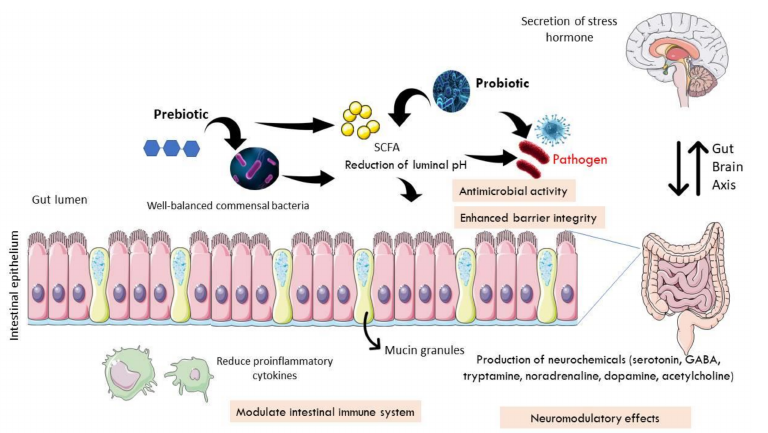
Figure 1. Mechanisms of prebiotic and probiotic action in modulating bidirectional gut − brain axis. A healthy human gut is unable to digest macronutrients, including plant-derived polysaccharides. Probiotics produce enzymes to digest the fibers and carbohydrates to produce short-chain fatty acids (SCFA) in the form of lactic acid and acetic acids. Prebiotics serve as a source of nutrition for the stimulation and propagation of commensal bacteria in the gut. The presence of SCFA reduces the pH of the intestinal lumen, preventing the growth of pathogen, or it has anti-microbial activity. Certain probiotic strains could restore the intestinal barrier function by increasing the expression of tight junction proteins as well as mucus-secretion genes. They also help modulate the intestinal immune system by reducing the amount of pro-inflammatory cytokines. In addition, probiotics exhibit neuromodulatory effects by enhancing neurochemical production in the gut, including serotonin, GABA, tryptamine, noradrenaline, dopamine, and acetylcholine. As cytokines and neurotransmitters will impair the integrity of the blood − brain barrier, this leads to potentially damaging effects of inflammatory or pathogenic elements that link to the central nervous system to secrete stress